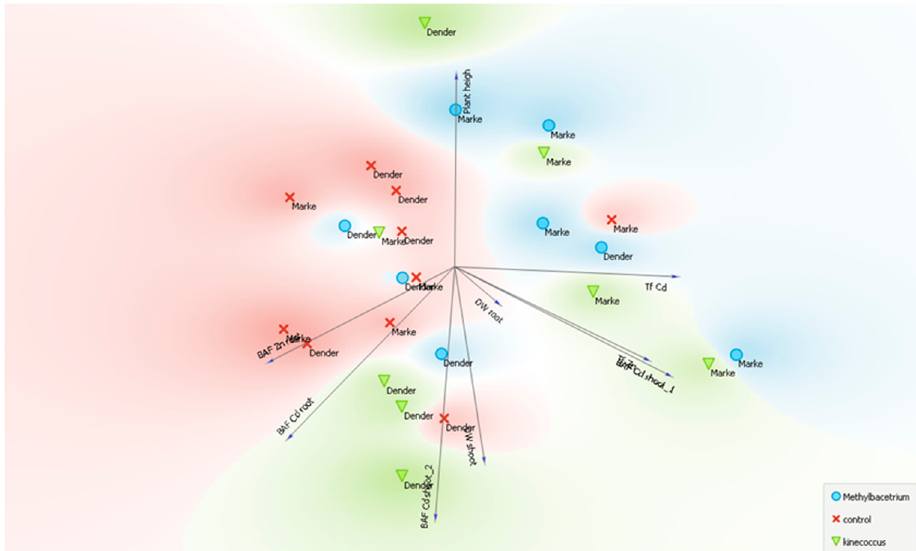
Figure 7. Principal component analysis computed with the main results of the experiment. Plant height refers to shoot length. Data obtained from different types of inoculation were reported in different colors and symbols. Control as red crosses (non-inoculated cuttings); Methylobacterium sp. CP3 inoculation as blue points; Kineococcus endophyticus CP19 inoculation as green